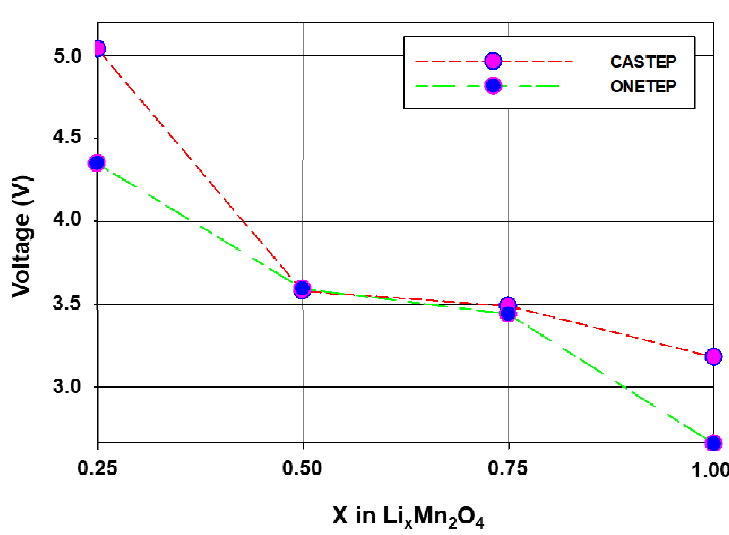
Figure 6. Comparison of ONETEP and CASTEP Open Cell Voltage (OCV) Li x Mn 2 O 4 (0.25 ≤ x ≤ 1). DoS of Li x Mn 2 O 4 (0 ≤ x ≤ 1) calculated with CASTEP and ONETEP: The electronic structure of spinel Li x Mn 2 O 4 with a lithium concentration range of 0 to 1 is illustrated by